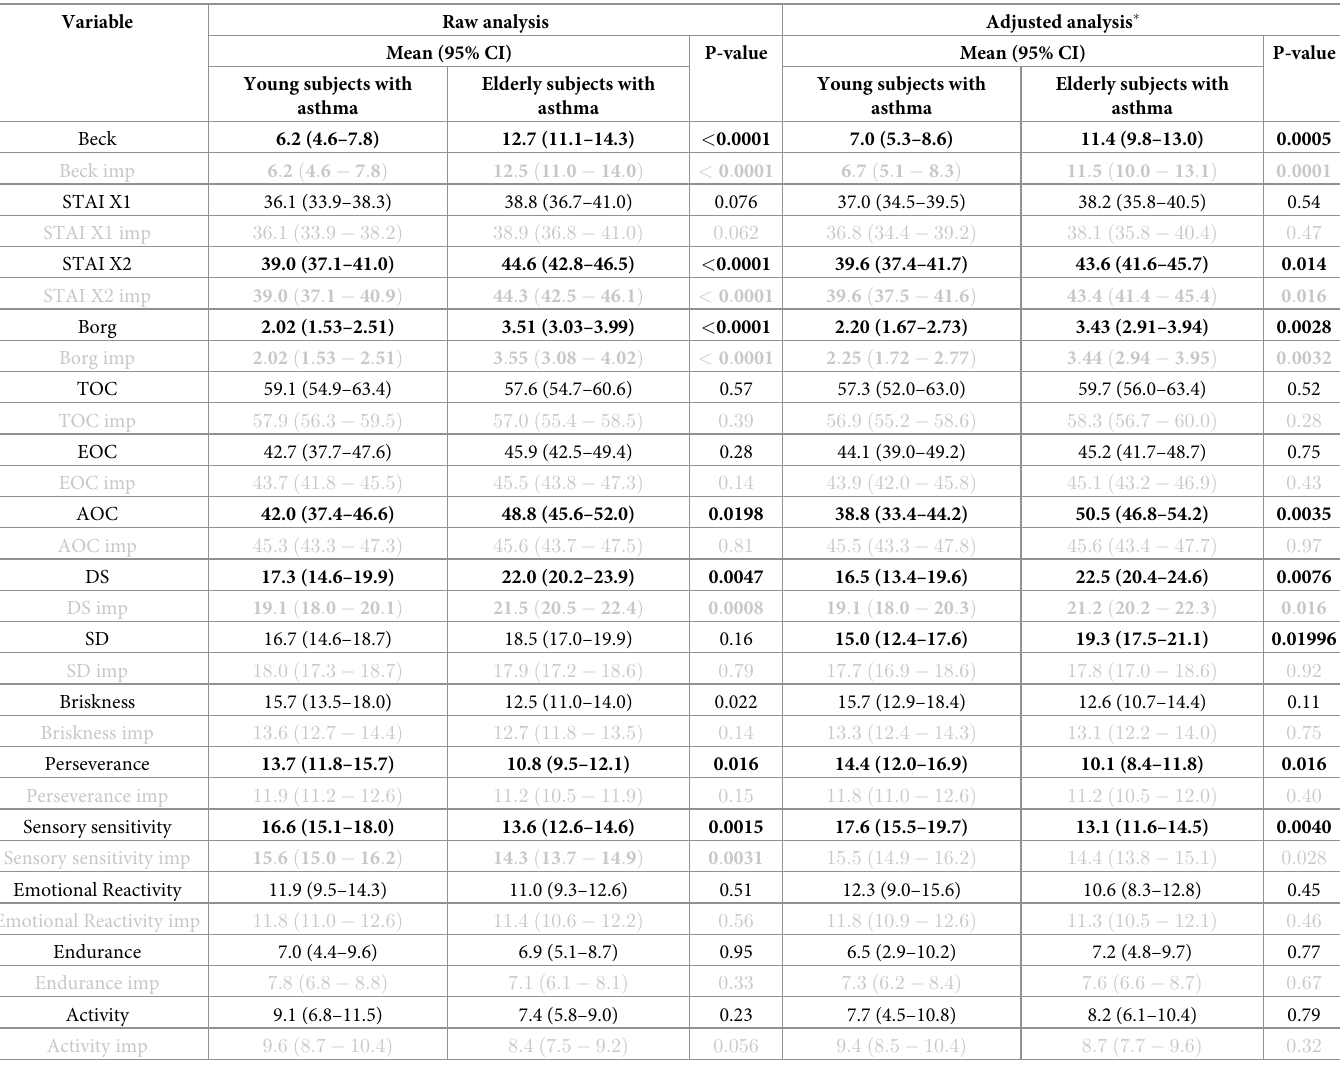
Table 3. Detailed description of analysis, of temperament components and stress coping strategies in the studied population of young and elderly asthmatics.